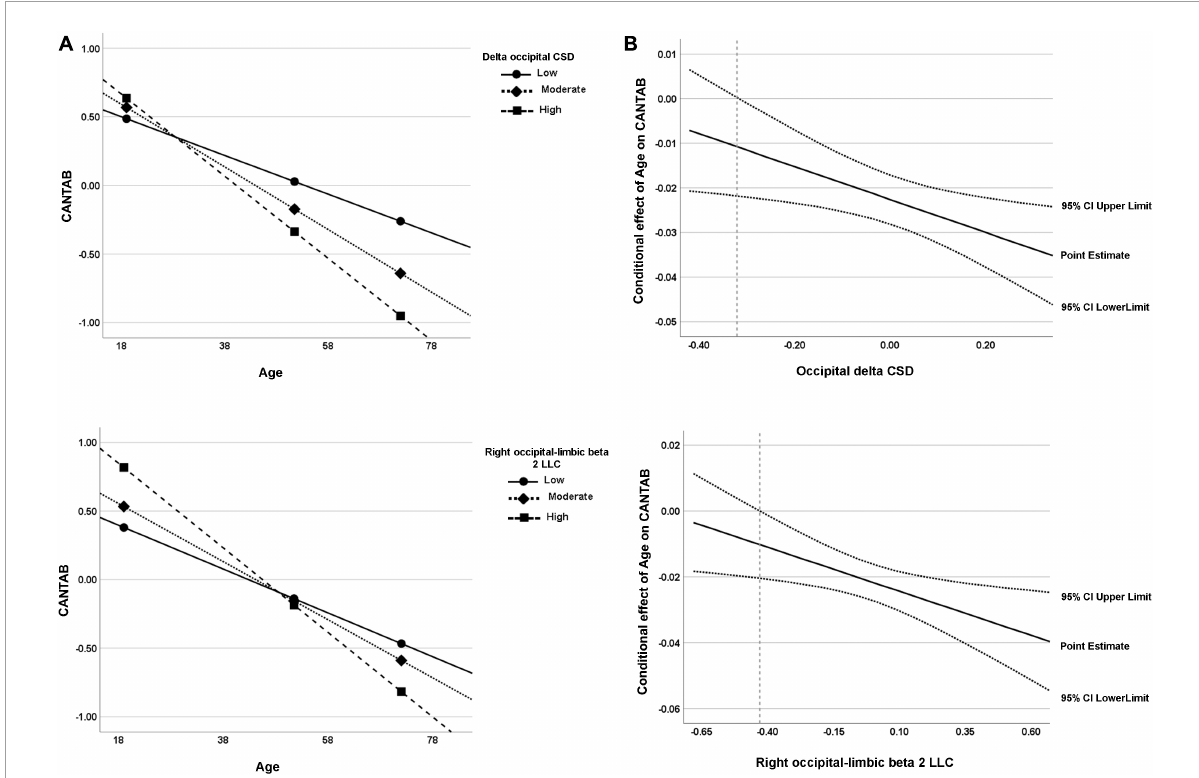
FIGURE7 (A) Visual representation of the analysis of the simple slope for the two significant moderators of the relationship between age and cognitive function (CANTAB composite score). Data are plotted with regression-based slopes corresponding to the conditional effect of age on cognitive function at low (16th percentile), moderate (50th percentile), and relatively high (84th percentile) levels of estimated rsEEG measures (delta occipital CSD and right occipital–limbic beta 2 LLC). (B) Region of significance derived from the J-N technique. The region of significance is depicted as the values of the moderator corresponding to points where a conditional effect of 0 is outside of the confidence band (dotted lines). In other words, the value of the moderator for which a value of 0 is not within the confidence interval. The value from which the confidence region is outside 0 is -0.32 for occipital delta CSD and − 0.43 for right occipital–limbic beta 2 LLC (dashed line). Both visual representations can be interpreted in the same way; for both measures, the higher the values, the higher the age-related cognitive